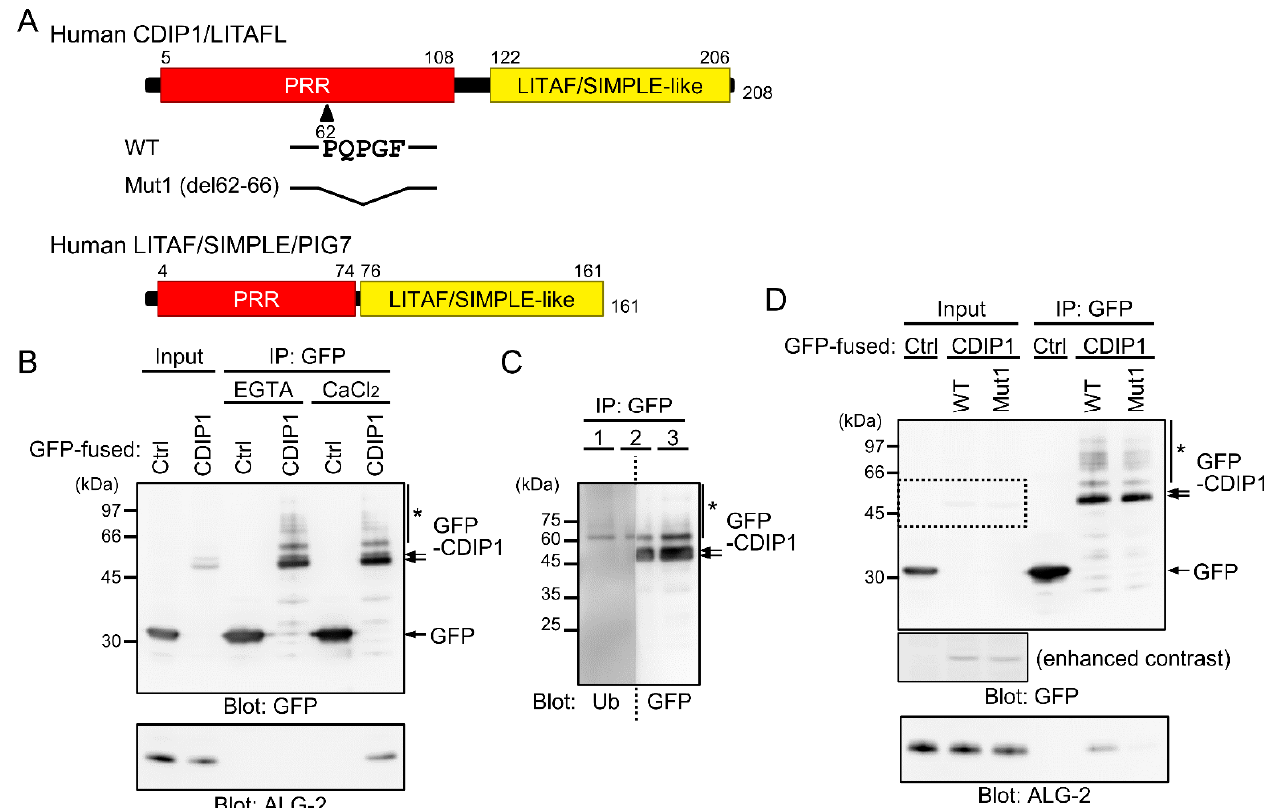
Figure 1. Ca 2+ -dependent interaction between apoptosis-linked gene 2 (ALG-2) and cell death-inducing p53 target protein 1 (CDIP1). ( A ) Schematic diagrams of human CDIP1/Lipopolysaccharide-induced tumor necrosis factor- α factor-like (LITAFL) and human Lipopolysaccharide-induced tumor necrosis factor- α factor (LITAF)/Small integral membrane protein of lysosome/late endosome (SIMPLE)/p53-induced gene 7 protein (PIG7) showing the N-terminal Pro-rich region (PRR) and the C-terminal LITAF/SIMPLE-like domain. CDIP1 contains an ALG-2 binding motif (ABM)-2-like motif ( 62 -PQPGF) in the PRR. ( B ) Co-immunoprecipitation (Co-IP) assay using HEK293 cells transiently expressing green fluorescent protein (GFP) (Ctrl) or GFP-fused CDIP1 (CDIP1) was performed as described in Materials and Methods. GST-fused GFP nanobody (GST-GFP nanobody) pre-bound to glutathione beads was added to the cleared cell lysate (Input) in the presence of 5 mM EGTA (EGTA) or 100 µ M CaCl 2 (CaCl 2 ), and cleared cell lysate proteins (Input) and immunoprecipitated proteins (IP) were analyzed by SDS-PAGE followed by Western blot (WB) with antibodies against GFP (upper panel) and ALG-2 (lower panel). The relative amounts of cleared cell lysate proteins (Input) used for analysis of IP products (IP) were 20% (upper panel) and 2.5% (lower panel). ( C ) Ubiquitination of GFP-CDIP1. IP products obtained with the GFP nanobody from HEK293 cells transiently expressing GFP-CDIP1 were resolved in three lanes (1 to 3) of an SDS-PAGE gel and the blotted membrane was cut into halves in the middle of the second lane. The left and right membranes were probed with monoclonal antibodies against ubiquitin (Ub) and GFP (GFP), respectively. Ubiquitinated GFP-CDIP1 bands are marked with asterisks. ( D ) HEK293 cells transiently expressing GFP (Ctrl), GFP-CDIP1 (WT) or GFP-CDIP1 Mut1 (Mut1) and IP products (IP) obtained with the GFP nanobody in the presence of 100 µ M CaCl 2 were subjected to SDS-PAGE followed by immunoblotting with antibodies against GFP (upper panel) and ALG-2 (lower panel). Contrast of the original image was decreased ( − 40%) to clearly show the bands for GFP-CDIP1 in the input lanes (enhanced contrast). The relative amounts of cleared cell lysate proteins (Input) used for analysis of IP products (IP) were 20% (upper panel) and 2.5% (lower panel). Arrows, non-ubiquitinated proteins; asterisks, slower-migrating ubiquitinated